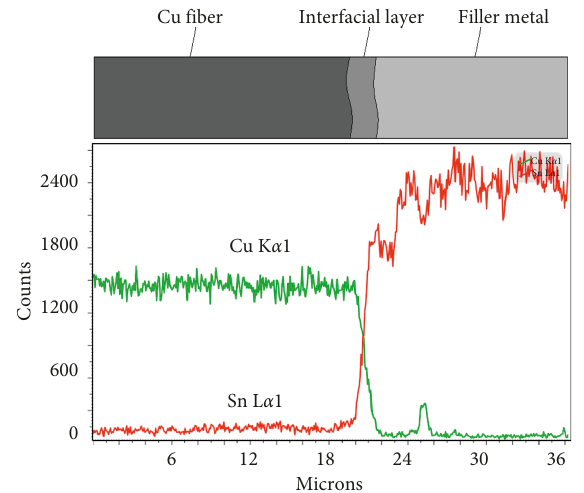
Figure 6: Line-scan EDX analysis of the interfacial area.